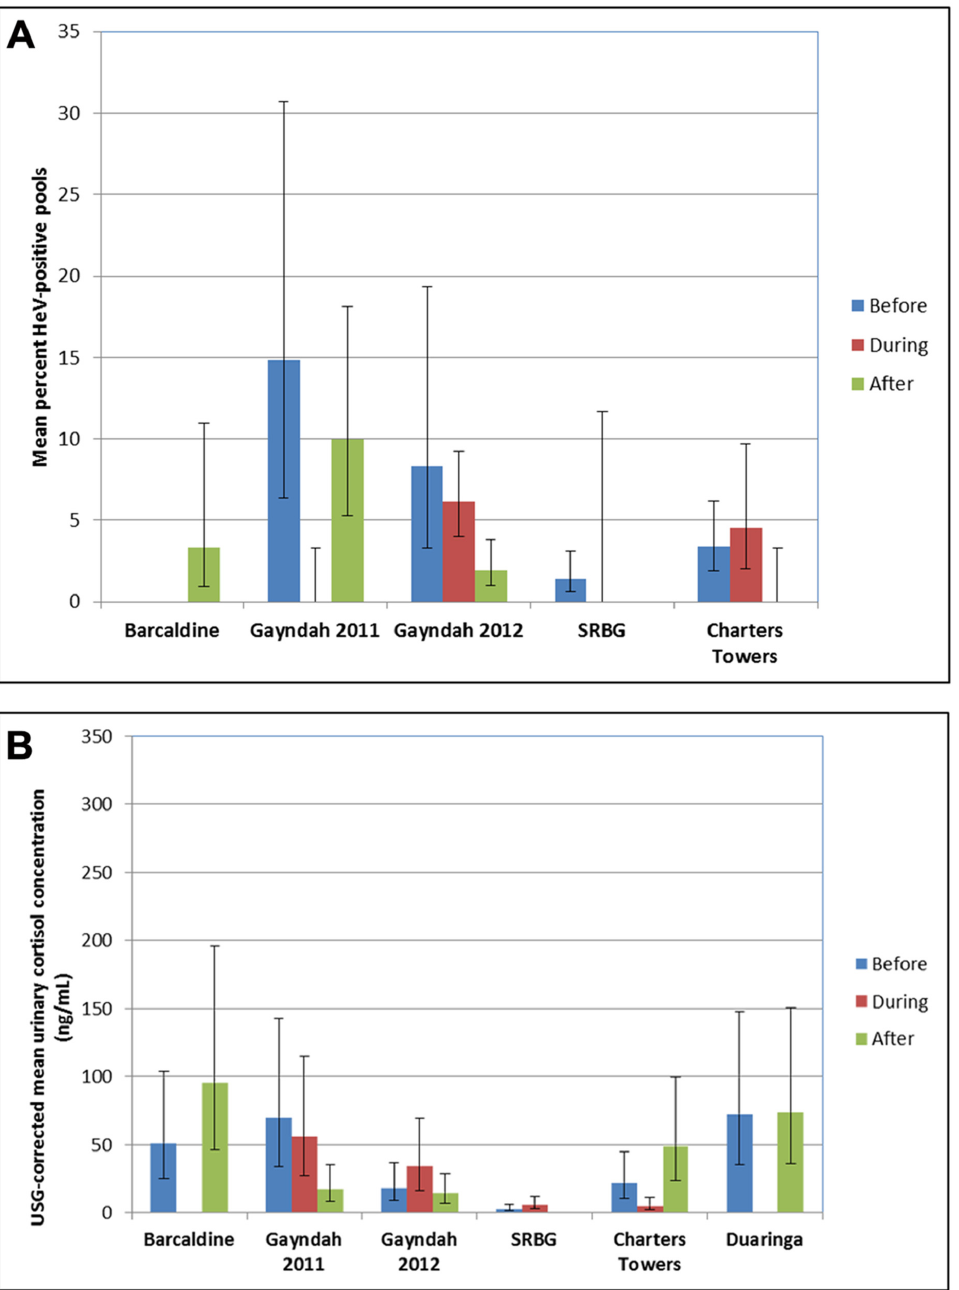
Fig 2. Adjusted mean HeV excretion prevalence (A) and adjusted USG-corrected urinary cortisol concentration (B) in six regions before, during and after permitted flying-fox roost disturbances in the eastern Australian states of Queensland and New South Wales between September 2011 and November 2012. Error bars represent the mean ± one standard error, obtained by back-transforming variance from the logistic scale. Approximate variance is used where HeV excretion prevalence is zero during (Gayndah 2011, SRBG) or after (Charters Towers) disturbance (A). Duaringa was excluded as HeV excretion prevalence was zero before, during and after disturbance (A). Respective baseline values using the same y-axis scale are presented in S1 Fig and S2 Fig.